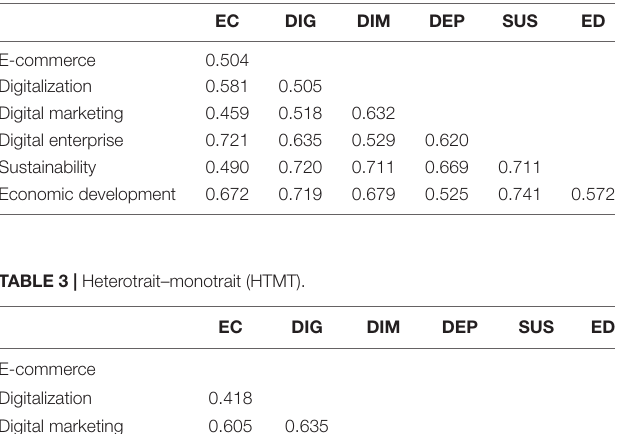
TABLE 2 | Fornell–Larcker criterion.